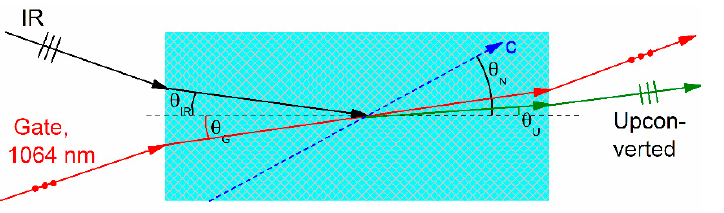
Figure 3. The upconversion experiment phase matching. Here c is the BBO crystal axis inclining at angle θ N = 41 ˚ to normal of the crystal face.